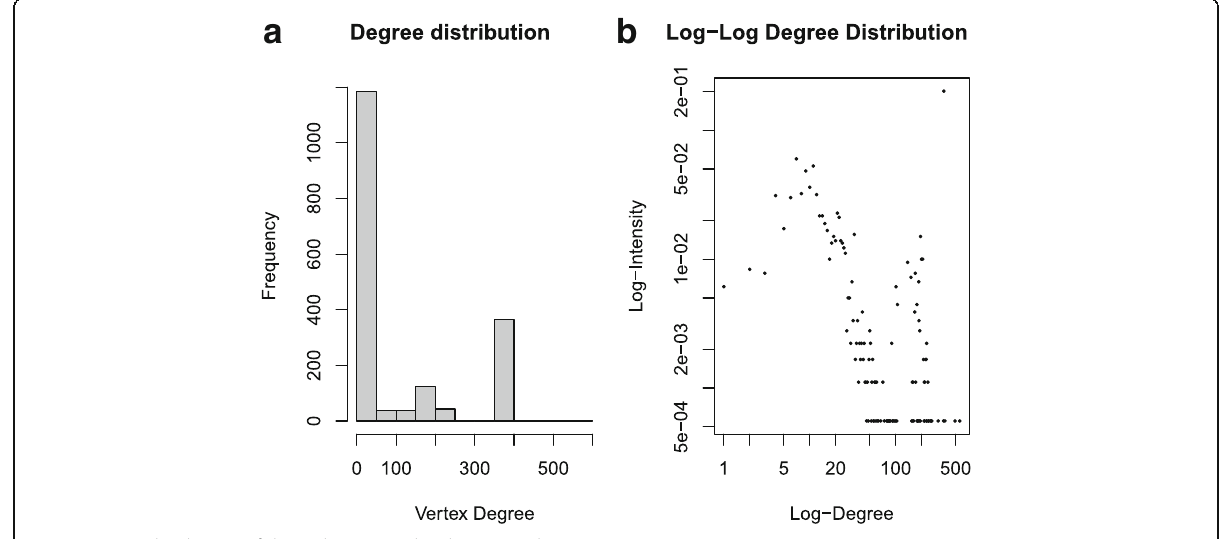
Fig. 1 Degree distribution of the Malaria Co-authorship